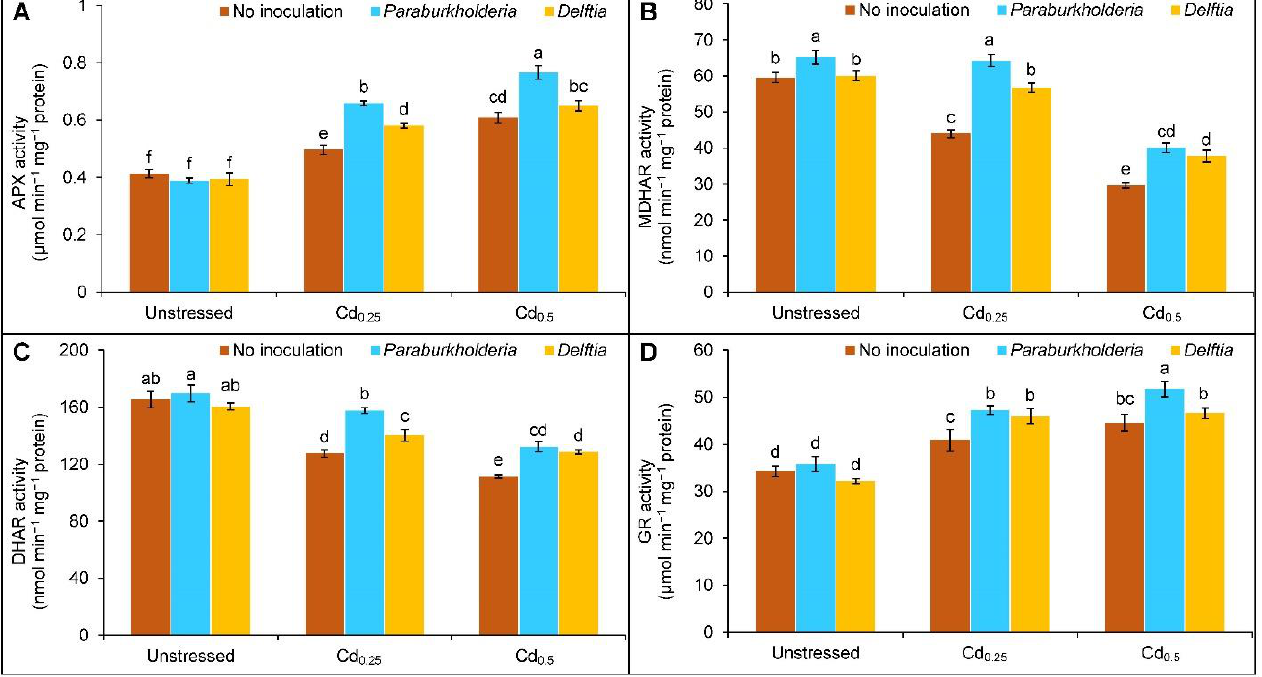
Figure 4. Effect of Paraburkholderia fungorum and Delftia sp. on the activities of ( A ) ascorbate peroxidase (APX), ( B ) monodehydroascorbate reductase (MDHAR), ( C ) dehydroascorbate reductase (DHAR), and ( D ) glutathione reductase (GR) of rapeseed under different levels of CdCl 2 . Here, Cd 0.25 and Cd 0.5 indicated 0.25 and 0.5 mM CdCl 2 , respectively. Different letters on the bars indicate statistical significance at 5% levels of probability following Tukey’s HSD test and the mean (±SD) values obtained from three replications.